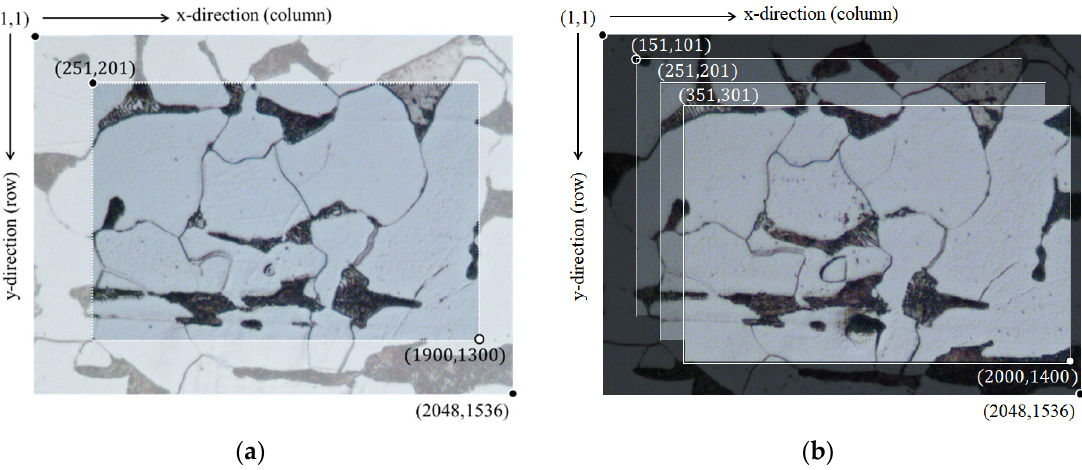
Figure 3. Area selection for local positioning. ( a ) Reference picture n th layer; ( b ) Target picture ( n + 1)th layer.